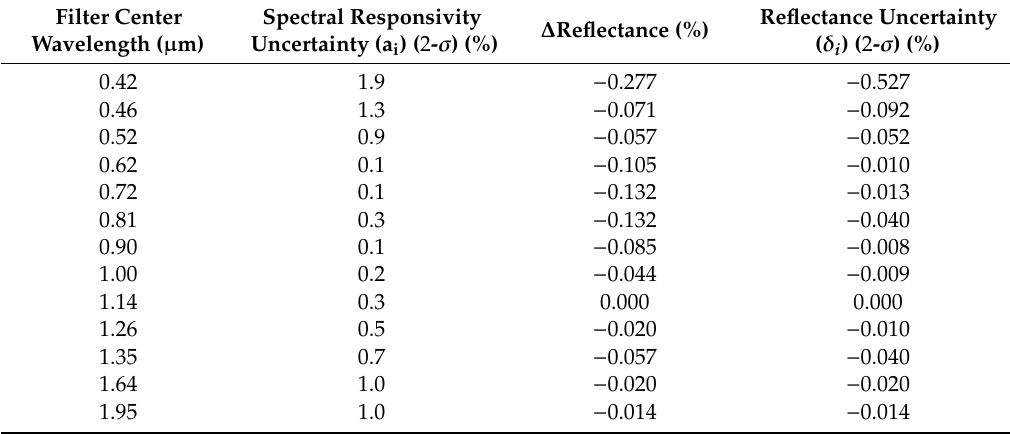
Table A1. Spectral responsivity uncertainty (a i ) and the Reflectance uncertainty ( δ i ) for global all-sky, as a function of filter center wavelength, obtained using SNPP / FM5 prelaunch calibration data and inter-comparison data sets, for the year 2014 (adapted from